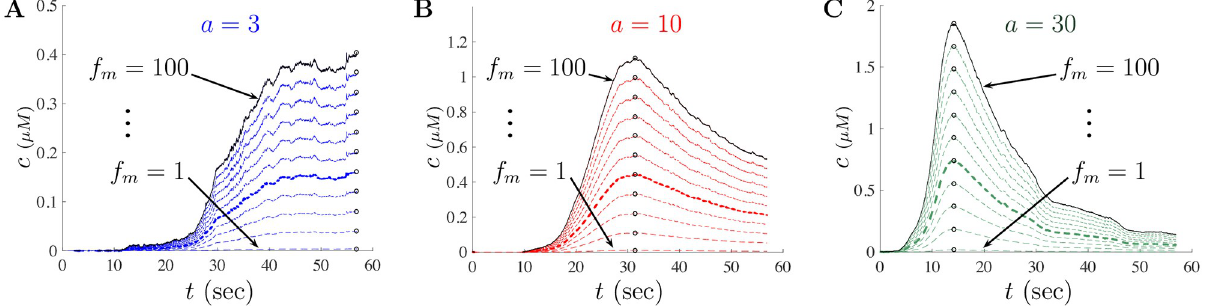
Fig 13. Impact of f m on rescaling of Ca 2+ data. Changes in scaled experimental data when f m ranges from 1 to 100. In all figures, R f = 100, KD = 0.3, and c 0 = 0.05. Figs A , B , and, C correspond to the scaled data for a = 3, a = 10, and a = 30, respectively. The maximum value of each scaled experimental data set is shown by the open circle. The bold color curve corresponds to f m = 40, the value used throughout the simulations.